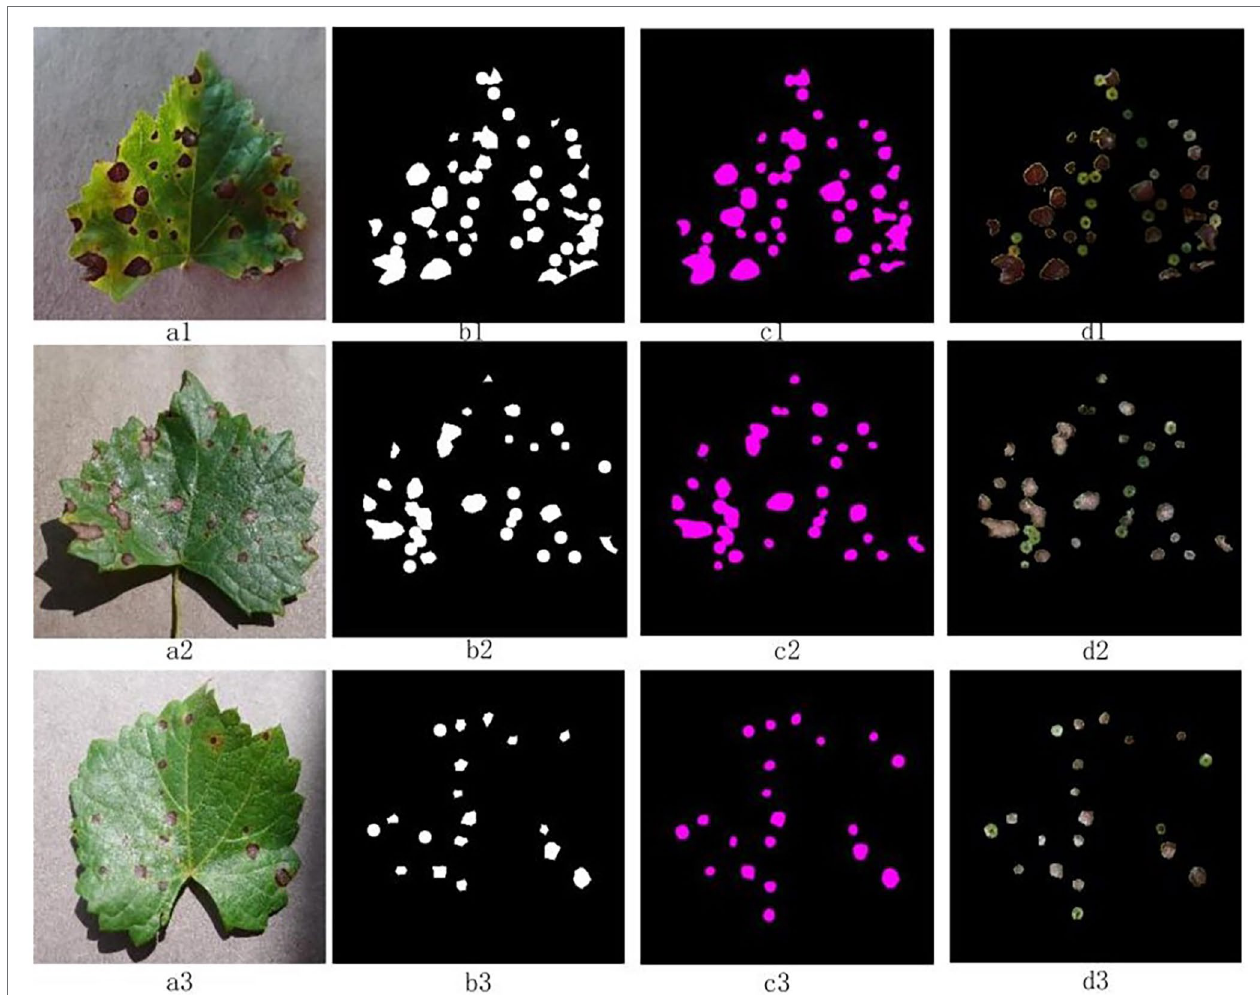
FIGURE 7 | Segmentation effects of the improved DeepLab v3+ on the test set TS1 image. The “a” column is the original image, the “b” column is the labeled mask, the “c” column is the segmentation result of the model, and the “d” column is the disease spot extraction